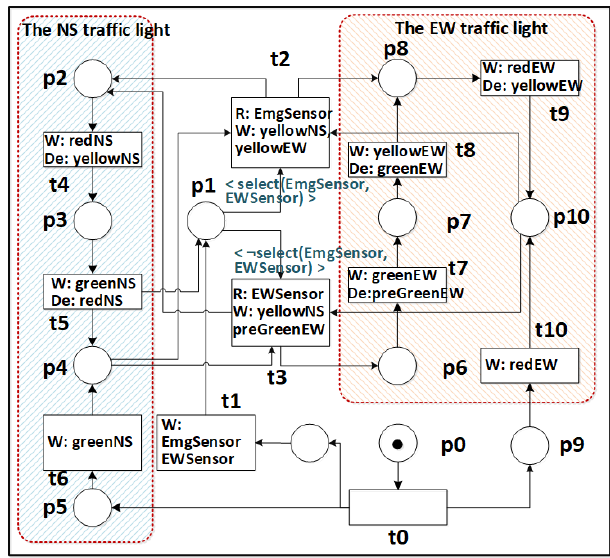
Figure 9. A WFD-net that models an intelligent traffic light system.